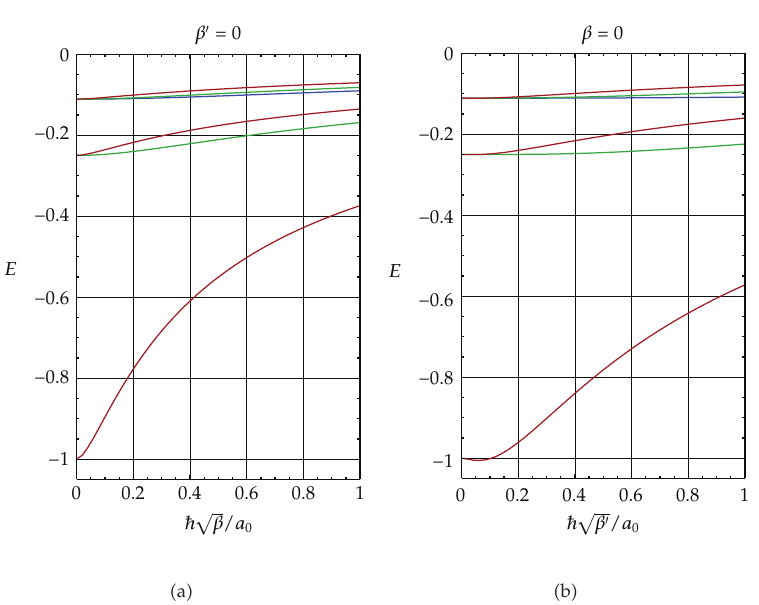
Figure 3: Energy shifts of the n (cid:4) 1 , 2, and 3 states of the Hydrogen atom for the β (cid:3) (cid:4) 0 (cid:5) left (cid:6) and β (cid:4) 0 (cid:5) right (cid:6) cases. a (cid:4) (cid:2) 2 /me 2 is the Bohr radius, and the energy is in units of the Rydberg constant e 2 / 2 a 0 The color of the lines indicates the orbital angular momentum: s (cid:5) red (cid:6) , p (cid:5) green (cid:6) , and d (cid:5) blue (cid:6) . The s - wave states are a ff ected nonperturbatively even for very small β or β (cid:3) , indicating their sensitivity to the singularity of the Coulomb potential at the